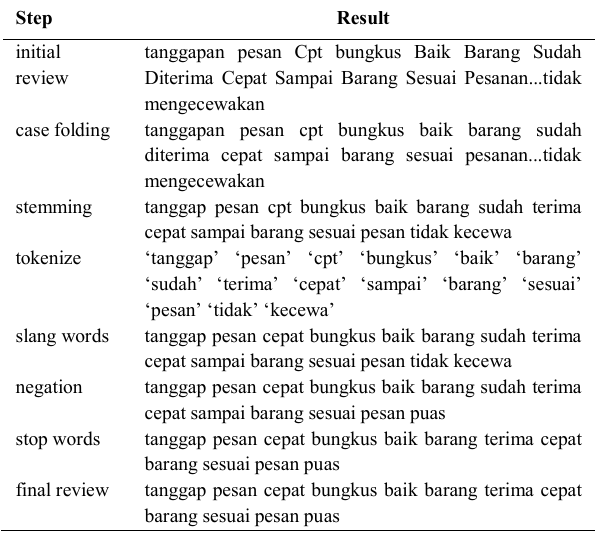
TABLE I PREPROCESSING SAMPLE RESULT